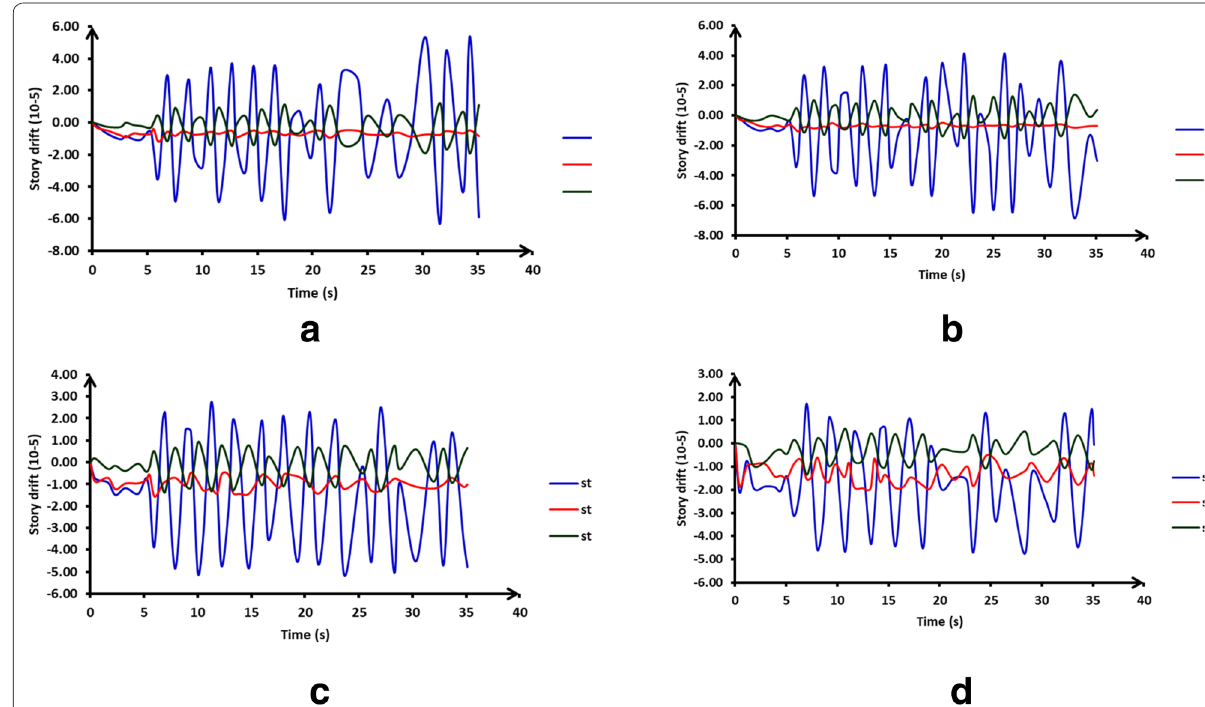
Fig. 17 The variation of time with story drift: ( a ) M0 ( b ) M10 ( c ) M15 ( d )